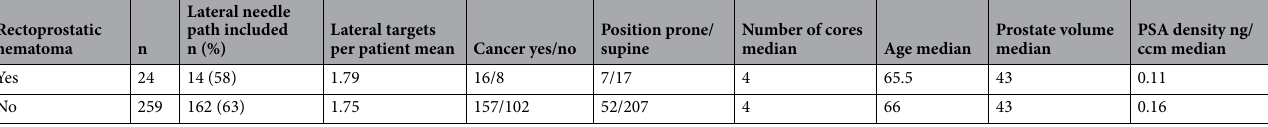
Rectoprostatic hematoma n